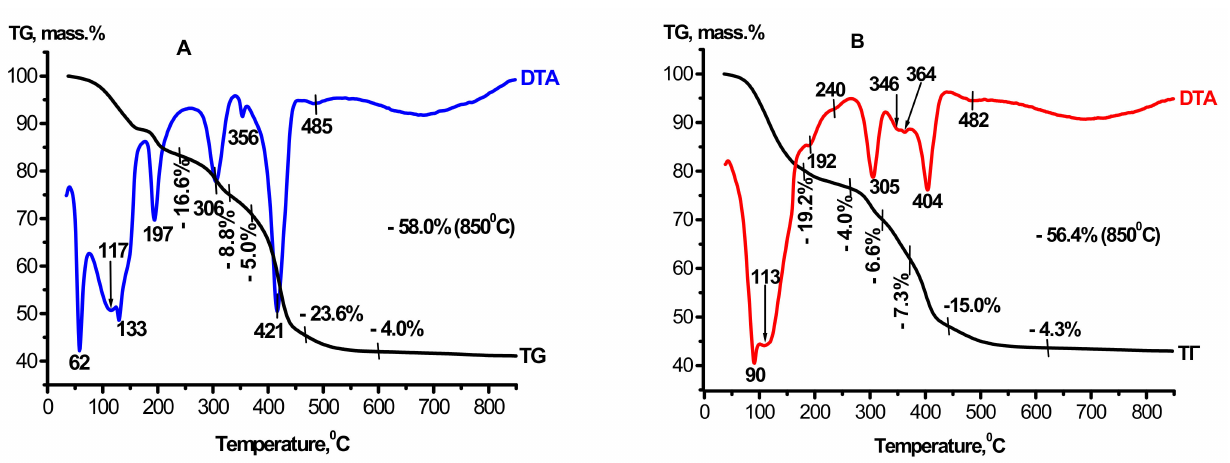
Figure 2. Data on thermal analysis of the samples: ( A )—MgAl(1)-110; ( B )—MgAl(2)-110. The graphs have been changed a